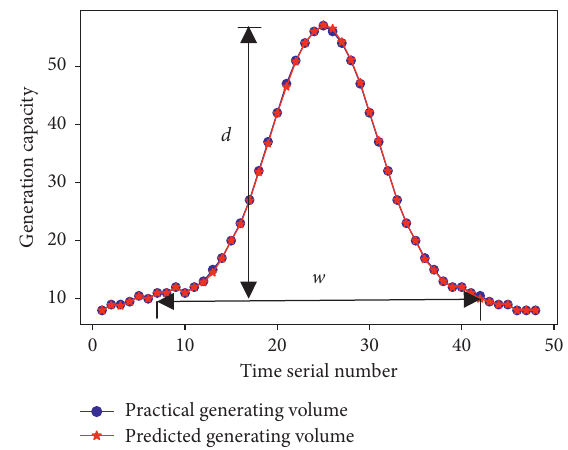
Figure 7: Forecast of one-day power generation in